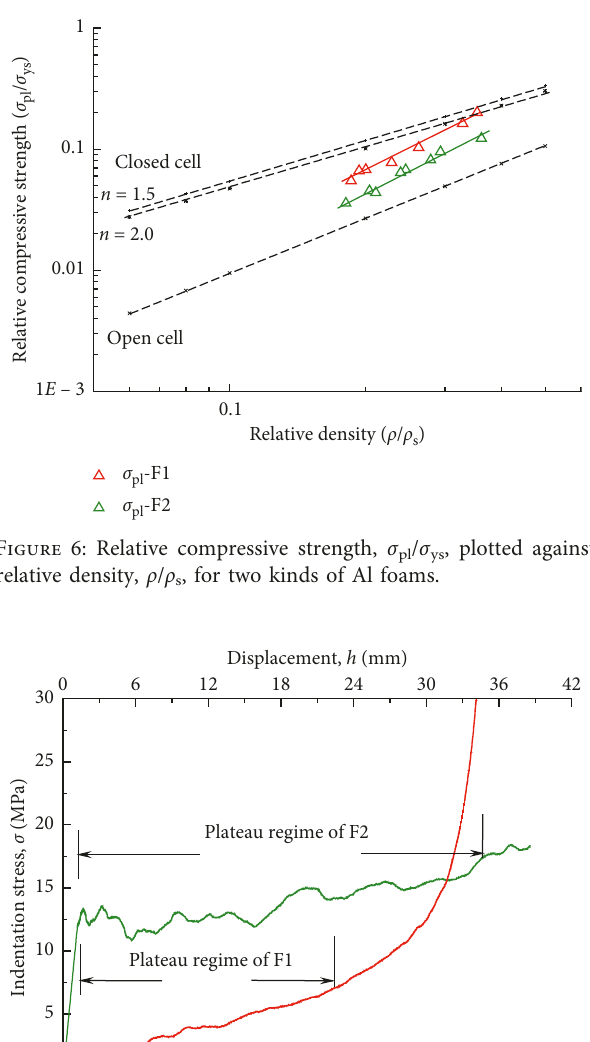
Figure 7: Indentation stress vs. nominal strain for two kinds of Al foams (F1 and F2) of comparable relative